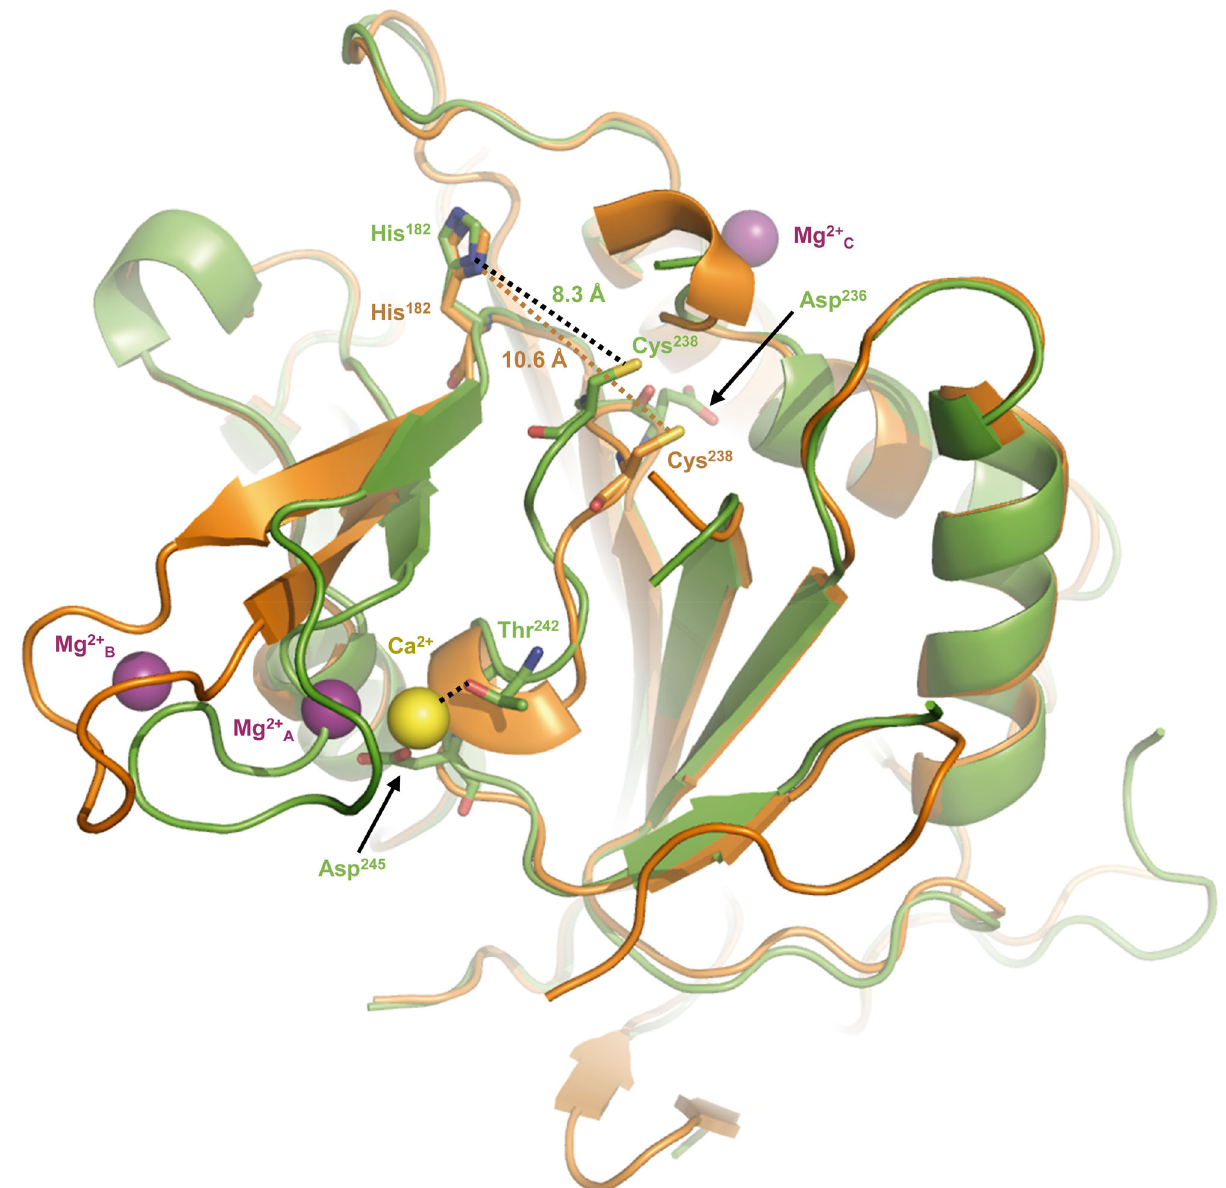
Fig. 4 Reorganization of the catalytic sites of Cg MCA-I Ca and Cg MCA-I Mg . The distance between the thiol group of the catalytic cysteine Cys 238 and the imidazole nitrogen of the catalytic histidine His 182 in the two crystal structures, with that of Cg MCA-I Ca shown in green and Cg MCA-I Mg in orange . Ca 2 + and Mg 2 + ions are shown as yellow and purple spheres,